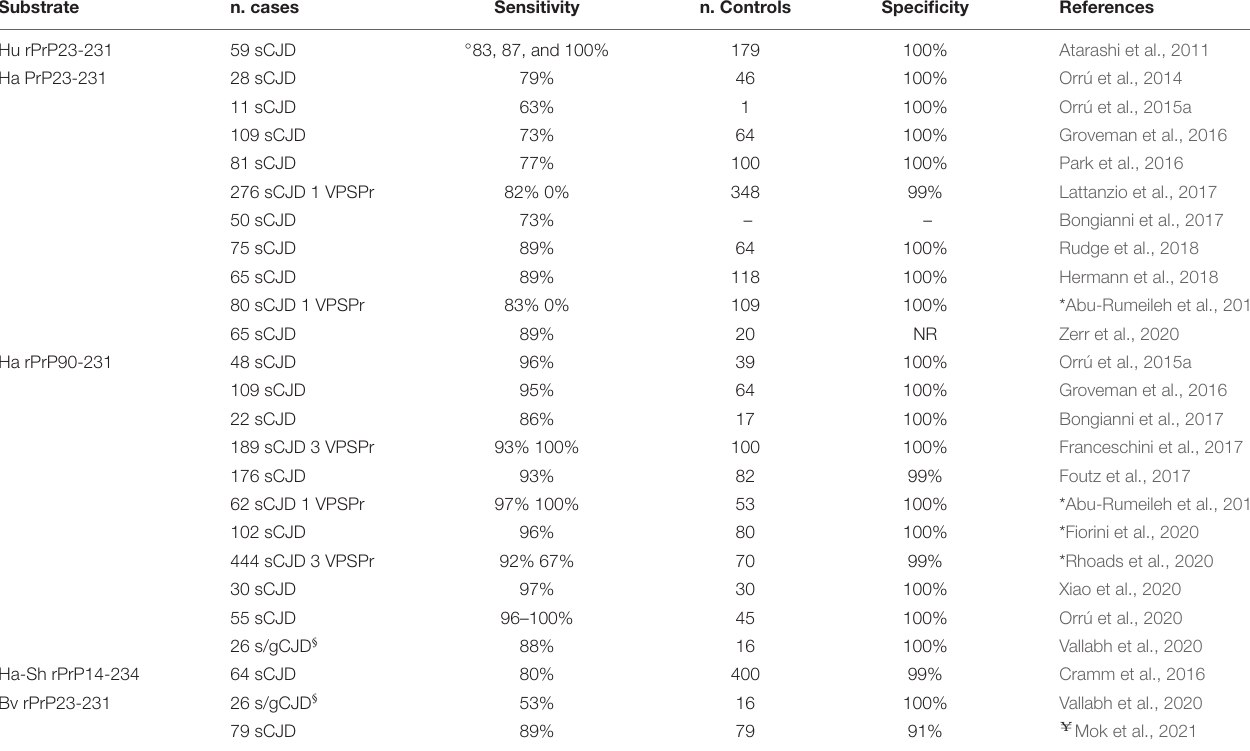
TABLE 3 | Performance of CSF-RT-QuIC in definite and/or probable sporadic prion disorders and controls (not-CJD and/or healthy subjects). Substrate n. cases Sensitivity n. Controls